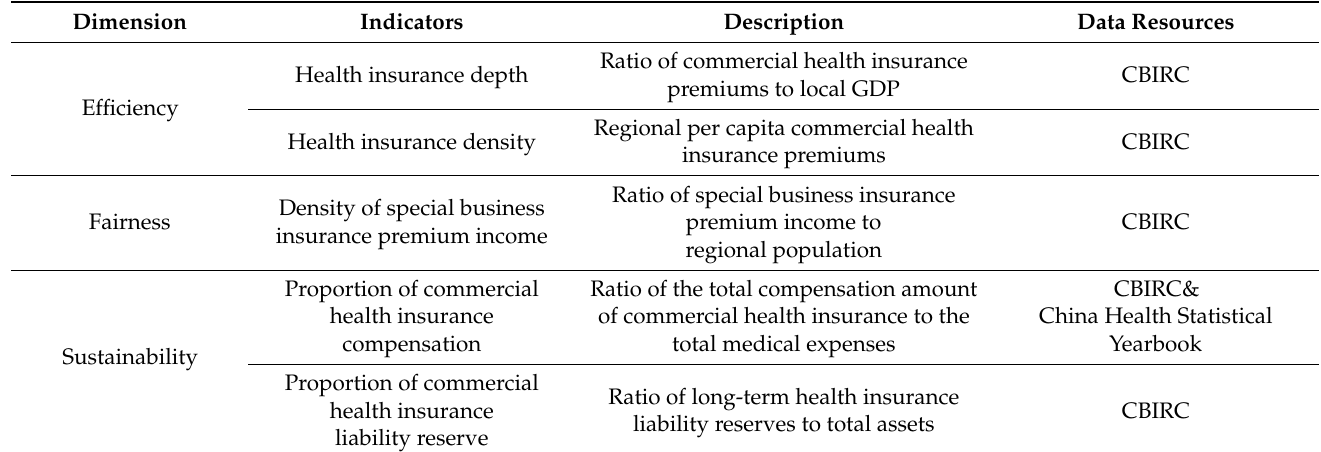
Table 1. Commercial Health Insurance Development Index